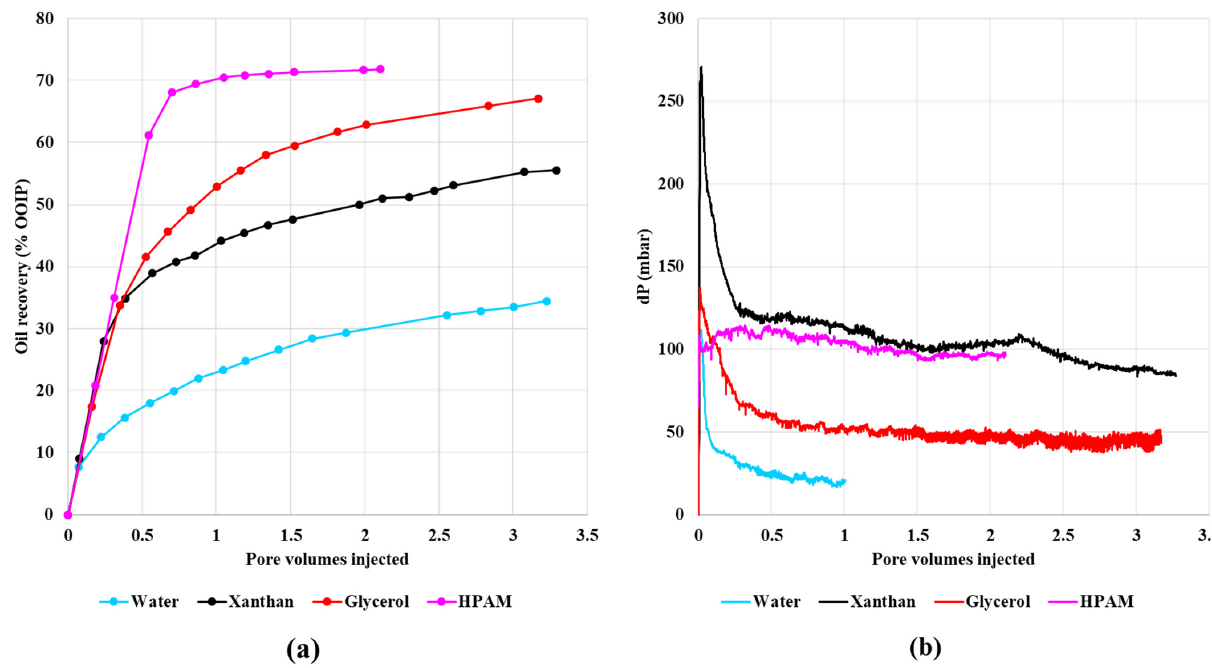
Figure 2. ( a ) Oil recovery and ( b ) differential pressure during secondary injections at an injection rate of 0.05 mL/min as a function of pore volumes. Based on data from Reference [21].